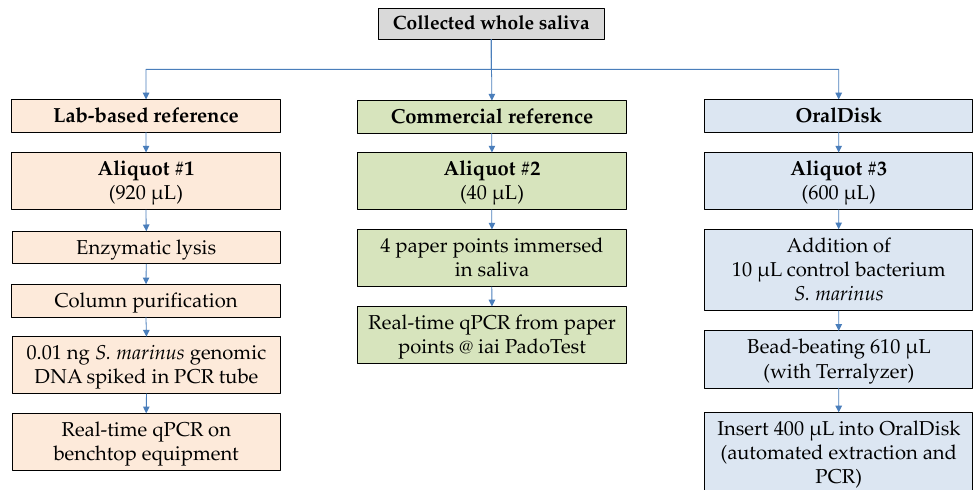
Figure 1. Experimental workflows from sample collection until analysis.